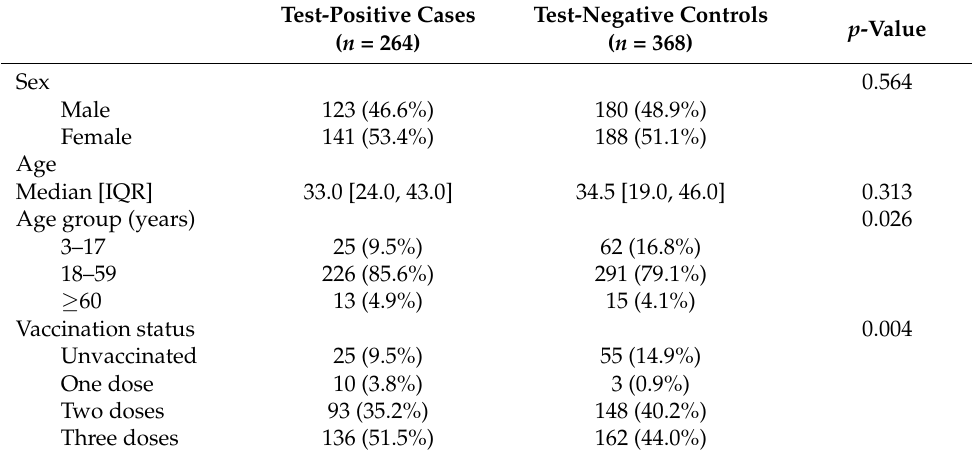
Table 1. Demographic and epidemiological characteristics of case and control groups ( n =